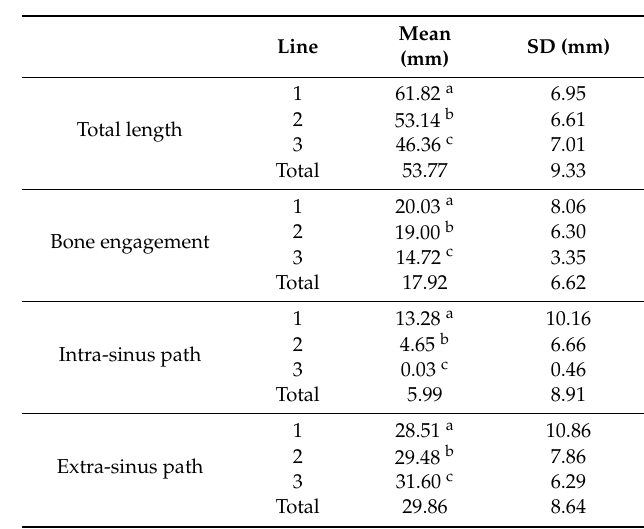
Table 1. Measurements on di ff erent trajectories. SD = standard deviation. Lines 1, 2, and 3 are the internal, intermediate, and external trajectories, respectively, and all the planes are included; a, b, c indicate significant di ff erences between lines 1, 2, and 3 for each variable (total length, bone engagement, intra-sinus path, extra-sinus path).